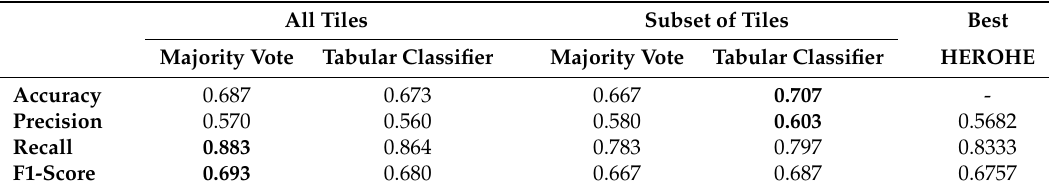
Table 2. Evaluation metrics for our two approaches and the leaderboard of the HEROHE challenge. In bold we highlight the best result obtained for each evaluation